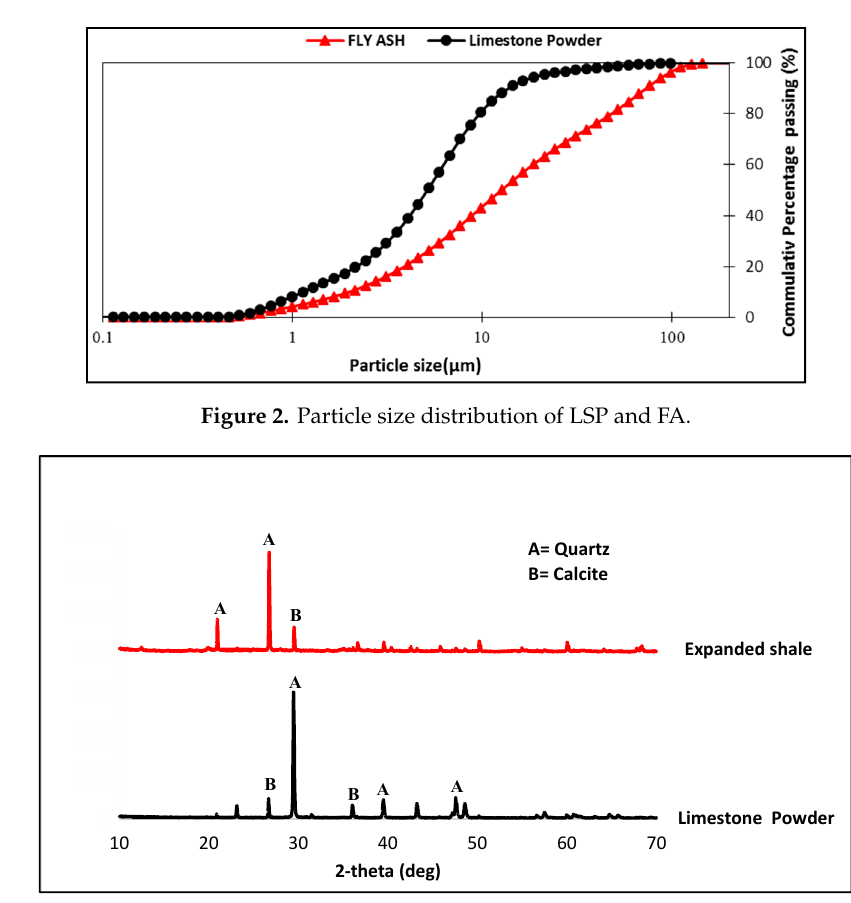
Figure 3. X-ray di ff raction pattern of expanded shale and limestone Figure 3. X-ray diffraction pattern of expanded shale and limestone powder. Table 3. Concrete mix proportions (kg/m 3 ). SCNWC, self-consolidating normal weight concrete; SCLWC, self-consolidating lightweight concrete.